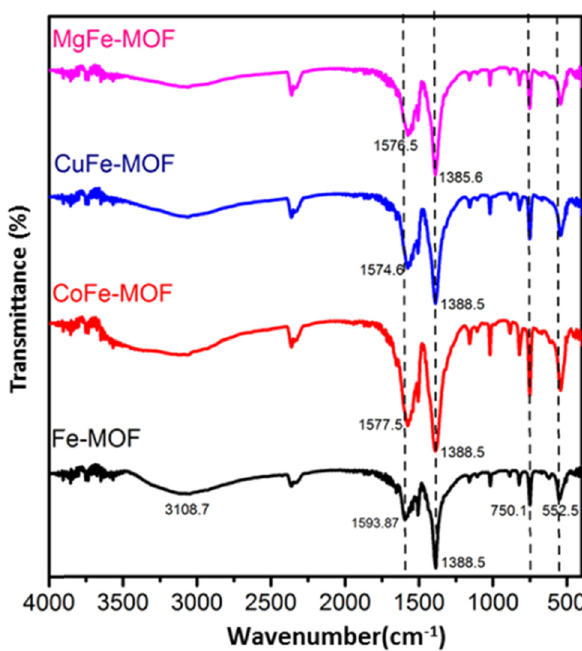
Figure 2: FTIR spectra of M/Fe - MOF ( M = Co, Cu, and Mg ) .